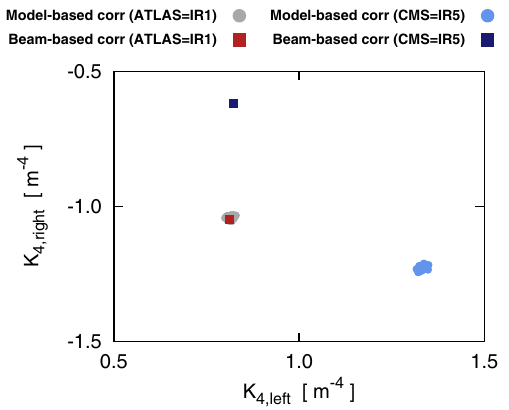
FIG. 7. Beam-based correction for normal octupole errors in the ATLAS (IR1) and CMS (IR5) insertions, compared to expected corrections based upon magnetic measurement. Sixty instances of model-based corrections are shown corresponding to the un- certainty in the magnetic measurements.